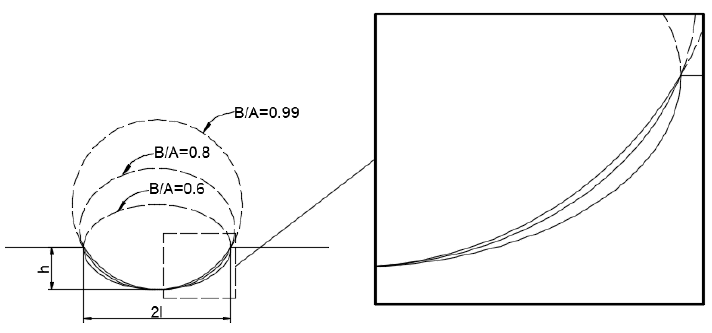
Figure 7. Di ff erent elliptical-arc canyons with the same depth-to-span ratio. Figure 7. Different elliptical-arc canyons with the same depth-to-span ratio. Figure 7. Different elliptical-arc canyons with the same depth-to-span ratio.